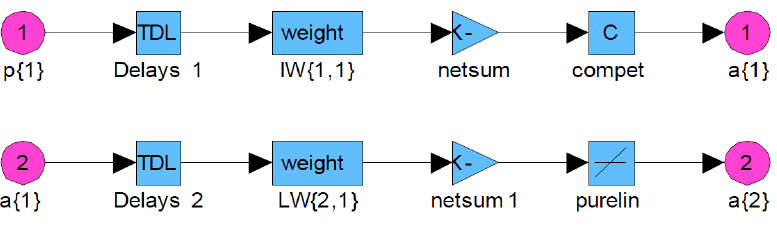
Figure 8. Internal structure of the driving pattern identifier.